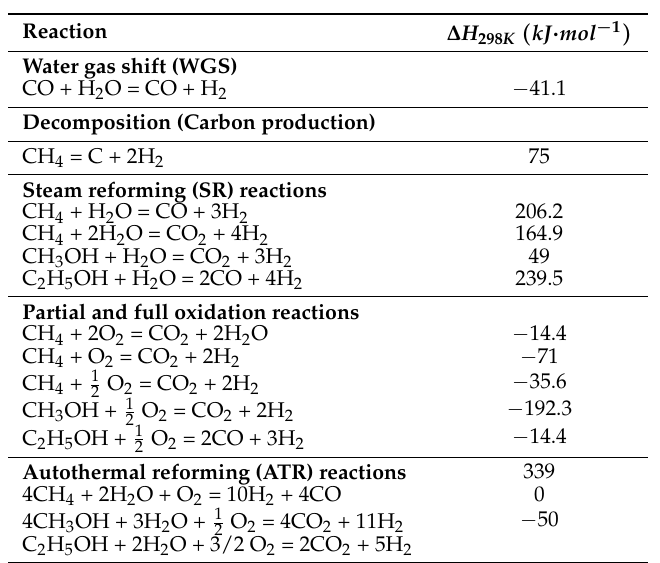
Table 1. Reactions involved in hydrogen production from methane, methanol and ethanol, and their enthalpies